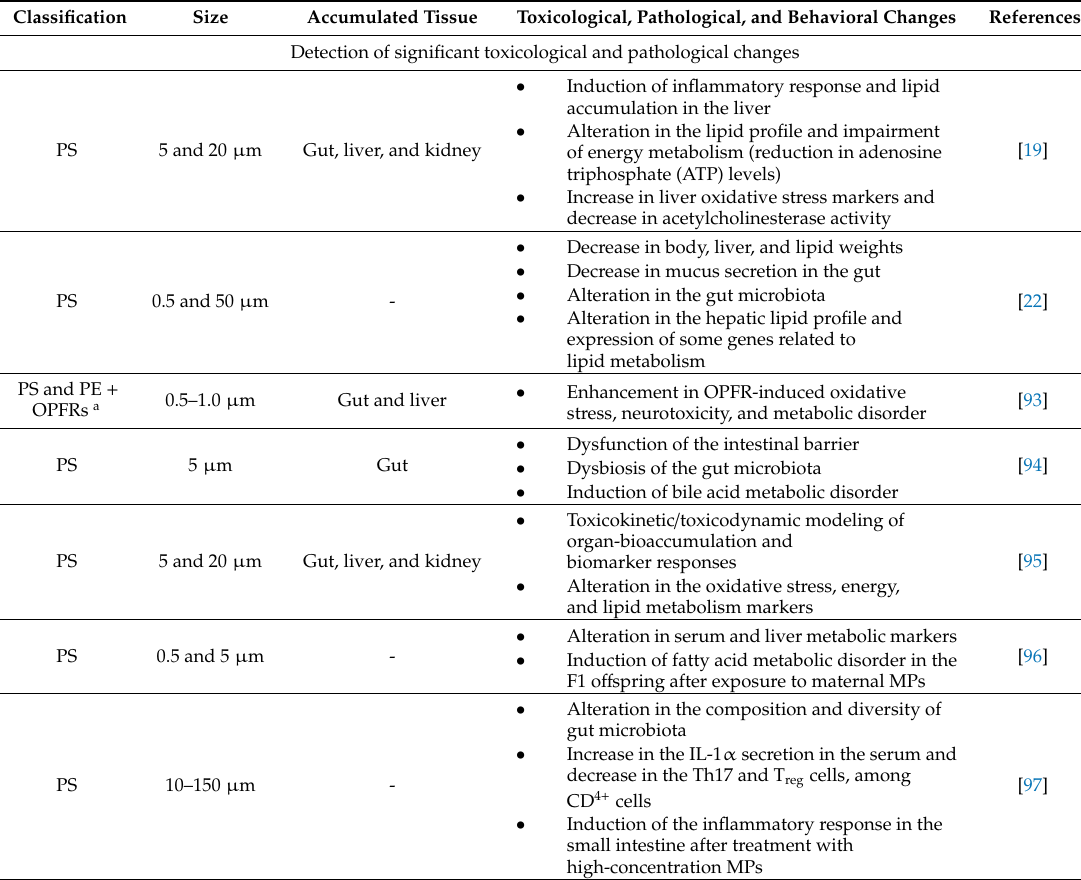
Table 3. The toxicological, pathological, and behavioral changes in mice and rats on MP/NP treatment. (We modified a summary table referred from [23].)